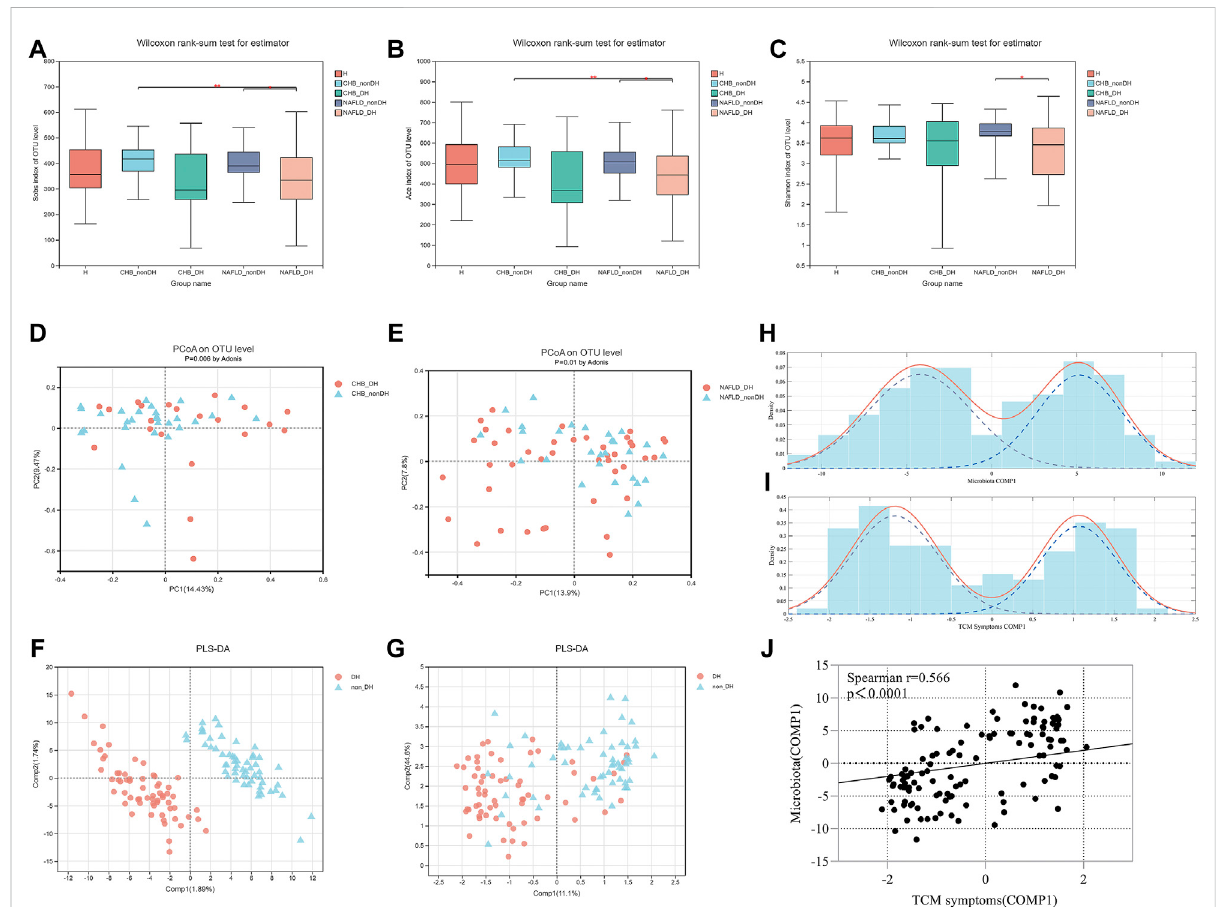
FIGURE 2 Comparison of α diversityand β diversityofgutmicrobial communitiesinpatientswithandwithoutDHsyndrome. (A) Sobsindex; (B) Aceindex; (C) Shannon index; PCoA with Bray-Curtis distance at OTU level based on (D) CHB_DH and CHB_nonDH individuals and (E) NAFLD_DH and NAFLD_nonDH individuals; (F) Score plot of PLS_DA analysis based on gut microbiota OTUs in patients with and without DH syndrome (the R 2 Y and Q 2 values for the model were 0.988 and 0.469, respectively); (G) Score plot of PLS_DA analysis based on TCM symptoms in patients with and withoutDHsyndrome(theR 2 YandQ 2 valuesforthemodelwere0.448and0.275,respectively);FiniteGaussianmixturemodelsofparametersof